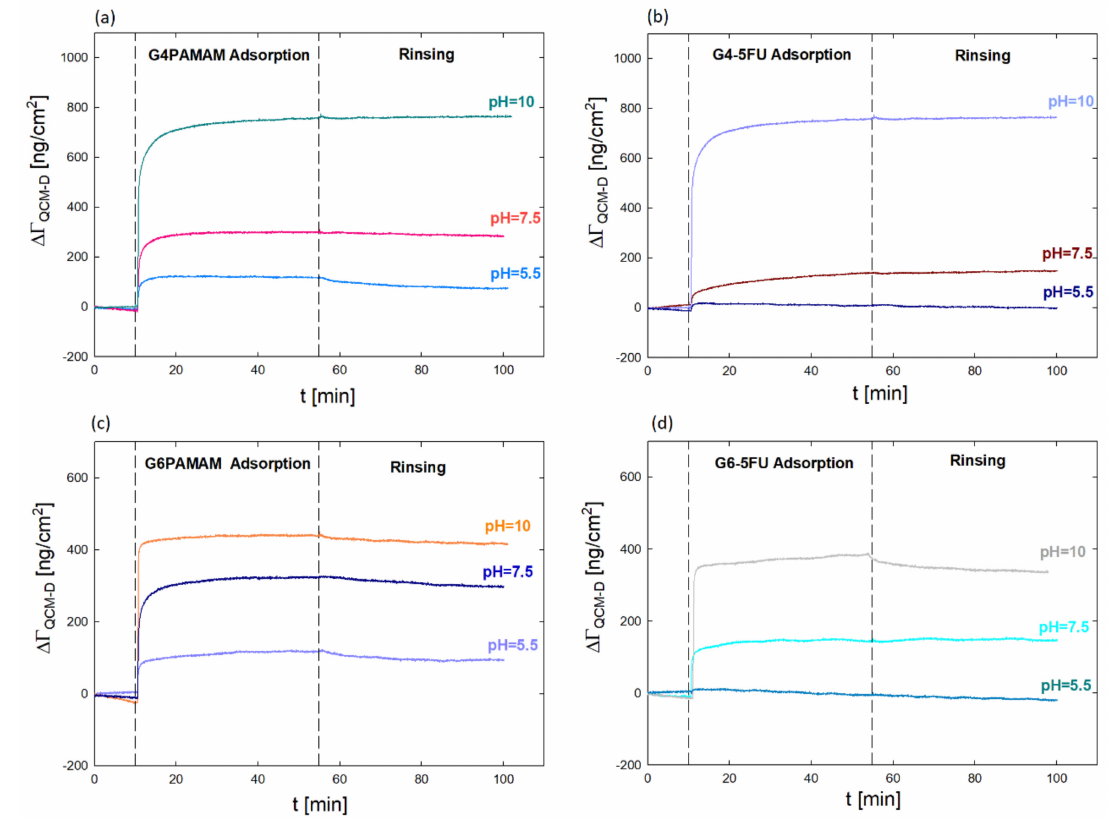
Figure 6. Comparison of the mass ( Γ QCM-D ) adsorbed on Au sensor surface using the QCM-D method for ( a ) G4PAMAM; ( b ) G4-5FU complexes after dialysis; ( c ) G6PAMAM ( d ) G6-5FU complex after dialysis on pH.